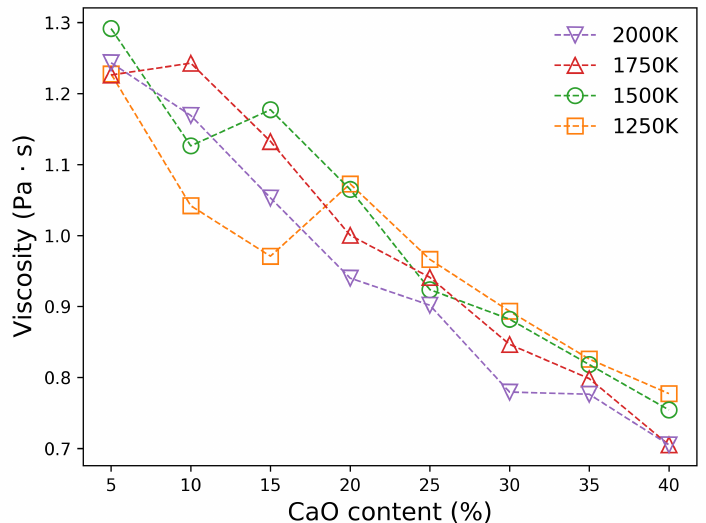
Figure 11. Simulated shear viscosity with NEMD as a function of CaO weight percentage for CaO–Al 2 O 3 –SiO 2 system.